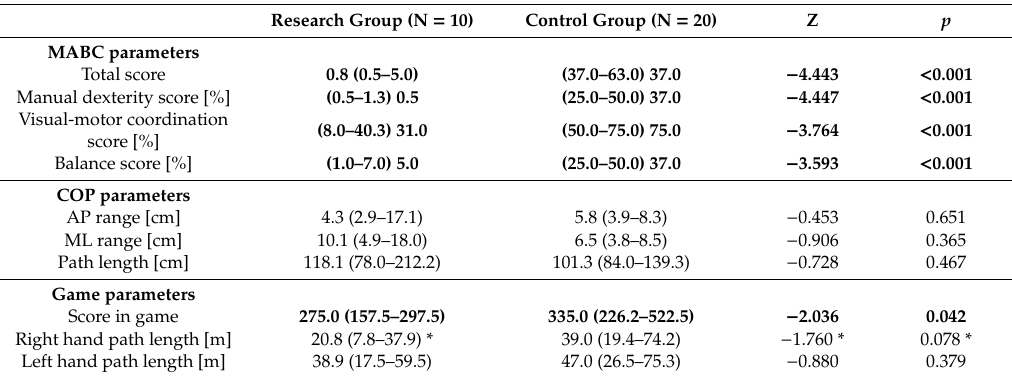
Table 2. Movement Assessment Battery for Children (MABC) scores, Center of Pressure (COP)-related parameters, hand path lengths and game score of the two groups, presented as median and interquartile percentages.